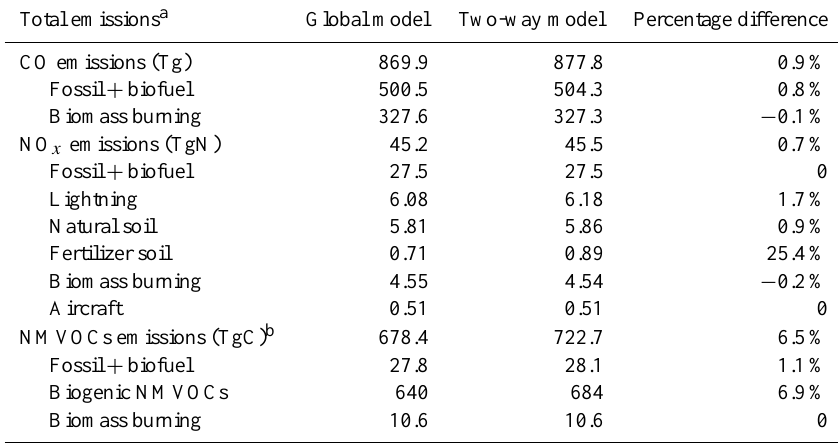
Table 2. Global emissions of CO, NO x and NMVOCs in GEOS-Chem for